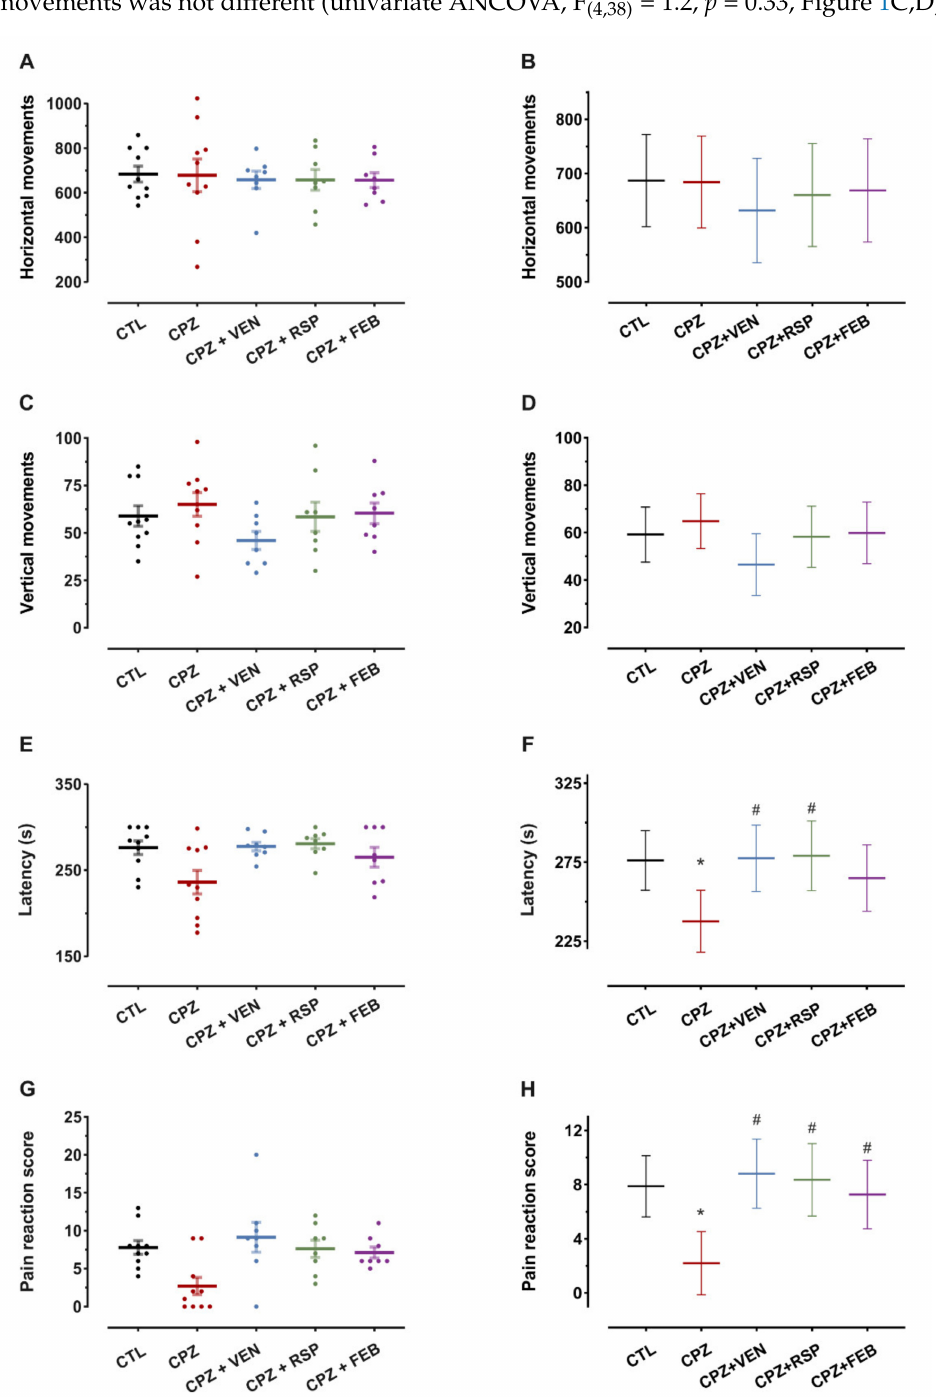
Figure 1. Behavioral tests following 5-weeks treatment. ( A ) Spontaneous locomotor activity—mean ± S.E.M (standard error of the mean) of total number of horizontal movements. ( B ) Mean and 95% confidence interval estimates of the horizontal movements after treatment. ( C ) Spontaneous locomotor activity—mean ± S.E.M of total number of vertical movements. ( D ) Mean and 95% confidence interval estimates of the vertical movements after treatment. ( E ) Motor coordination— mean ± S.E.M of latency (s) of falls off the rotating drum. ( F ) Mean and 95% confidence